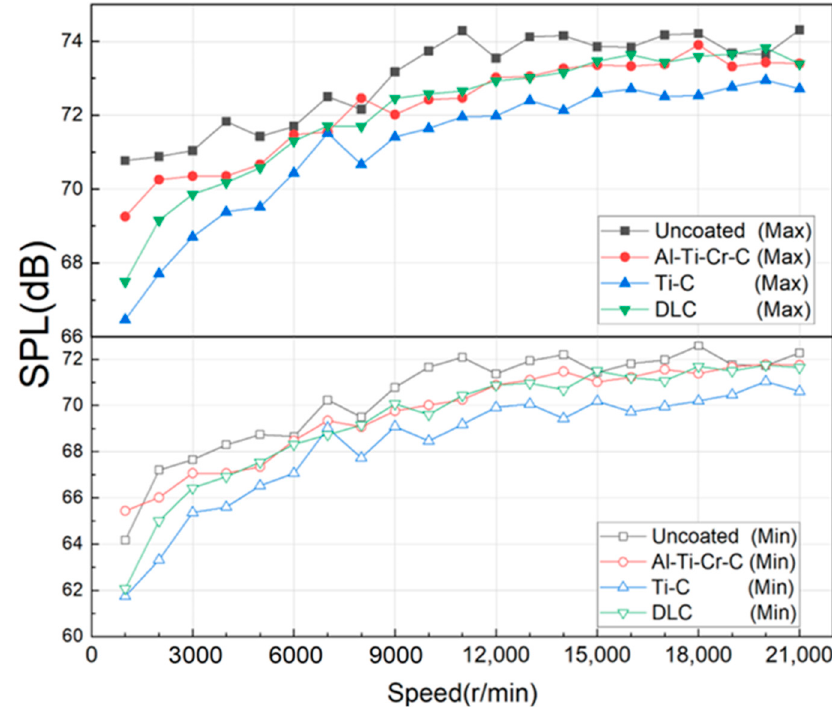
Figure 11. Maximum value of the spindle sound pressure level–speed graph.